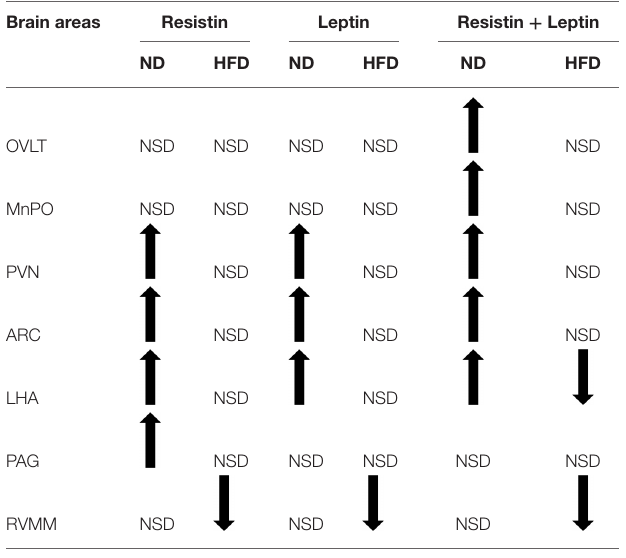
Supplementary Figure VII | A schematic showing the approximate region of the periaqueductal gray (PAG) and dorsal raphe nucleus (DR) in which fos-positive cell nuclei were counted. The photomicrograph is an example of a section counted. The approximate rostrocaudal level relative to bregma is given in mm. Supplementary Figure VIII | A schematic showing the approximate region of the RVLM, the medullary midline area Raphe pallidus (RPa) and rostral ventromedial medulla (RVMM) in which fos-positive cell nuclei were counted. The photomicrograph is an example of a section counted. The approximate rostrocaudal level relative to bregma is given in mm. AP, area postrema; ION, inferior olivary nucleus; NA, nucleus ambiguous; Pyr, pyramidal tract. All supplementary figures are modified from Paxinos and Watson